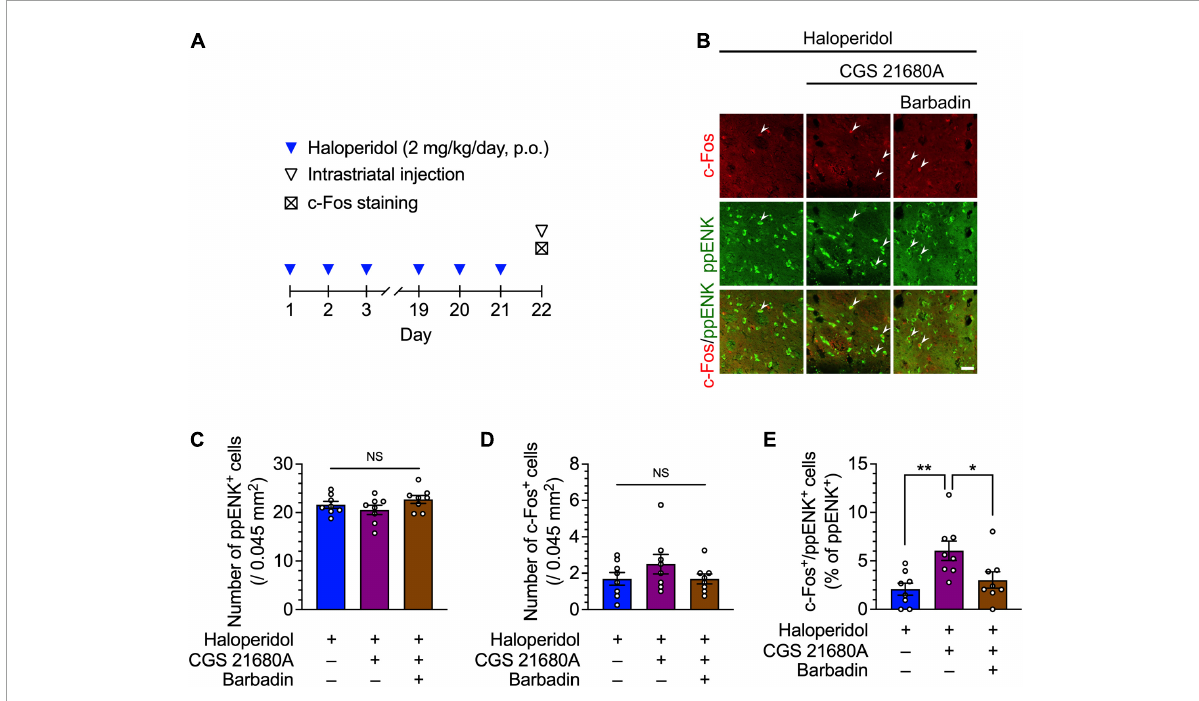
FIGURE3 Effects of the dorsostriatal injection of CGS 21680A and barbadin on dorsostriatal iMSN activity in mice after 21 days of treatment with haloperidol. (A) Experimental protocol for immunostaining of iMSNs following dorsostriatal injection of CGS 21680A and barbadin. (B–E) Mice ( n = 8 per group) were orally administered haloperidol (2 mg/kg/day) daily for 21 days; 23 h after the last administration of haloperidol, these mice received vehicle, CGS 21680A (1 ng/side), CGS 21680A (1 ng/side) + barbadin (300 ng/side). After 65 min, coronal sections containing the dorsal striatum were prepared, stained with anti-c-Fos and anti-ppENK antibodies, and imaged using confocal microscopy. The number of (C) ppENK + cells (D) and c-Fos + cells were counted. (B,E) The number of c-Fos + /ppENK + cells (shown by arrowheads) were counted and are presented as percentages of the number of ppENK + cells, reflecting the total number of iMSNs. Scale bars = 30 µ m. Individual data are shown as the mean ± SEM. Statistical significance was tested using one-way ANOVA with a post hoc Tukey’s test. * P < 0.05; ** P < 0.01. NS, not